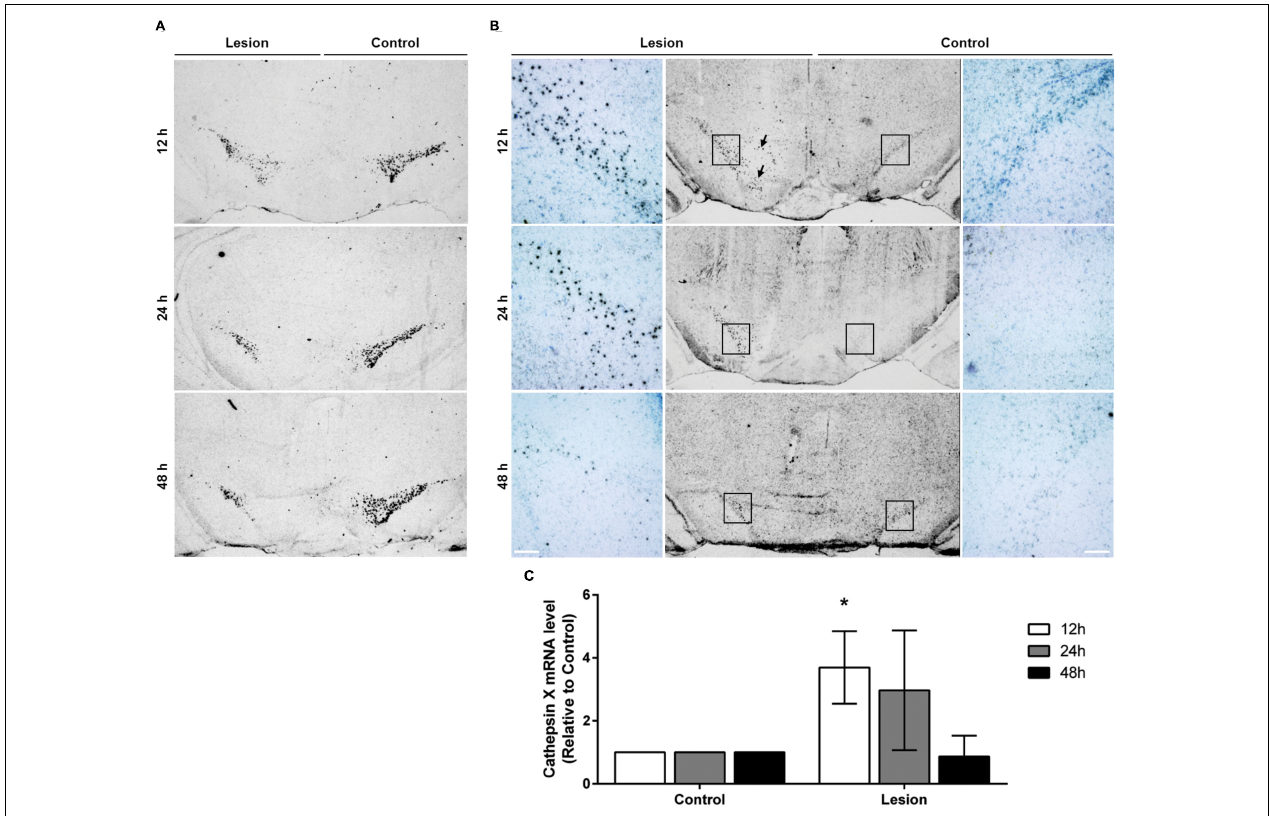
FIGURE 1 | The expression pattern of TH and cathepsin X mRNA in the SNc after 6-OHDA injection. Representative in situ hybridization histochemistry images of coronal midbrain sections of the SNc from the 12, 24, and 48 h time points after 6-OHDA-induced lesion. (A) TH mRNA seen as clusters of silver grains, shows reduced TH mRNA expression in the ipsilateral SNc (Lesion) at all time points indicated, in comparison to the contralateral side (Control). (B) 6-OHDA-induced lesions at 12 and 24 h increased cathepsin X mRNA expression in the ipsilateral SNc (Lesion) compared to the contralateral side (Control). At 12 h, on the ipsilateral side, cathepsin X mRNA-positive signals were also observed in the VTA region (black arrow). At 48 h after 6-OHDA injection, the intensity and density of increased cathepsin X mRNA in the ipsilateral SNc were lower than those for cathepsin X mRNA signals at 12 and 24 h. For each condition, a group of four animals ( n = 4) was analyzed and four sections of the SNc region of each animal were analyzed. Scale bar s = 200 µ m. (C) Semi-quantification of cathepsin X mRNA expression. The graph represents the average of the in situ hybridization signal for cathepsin X of the ipsilateral SNc (Lesion) expressed relative to contralateral SNc (Control) from the 12, 24, and 48 h time-points after 6-OHDA-induced lesion. Values are means ± SD of group of four animals. ∗ P <